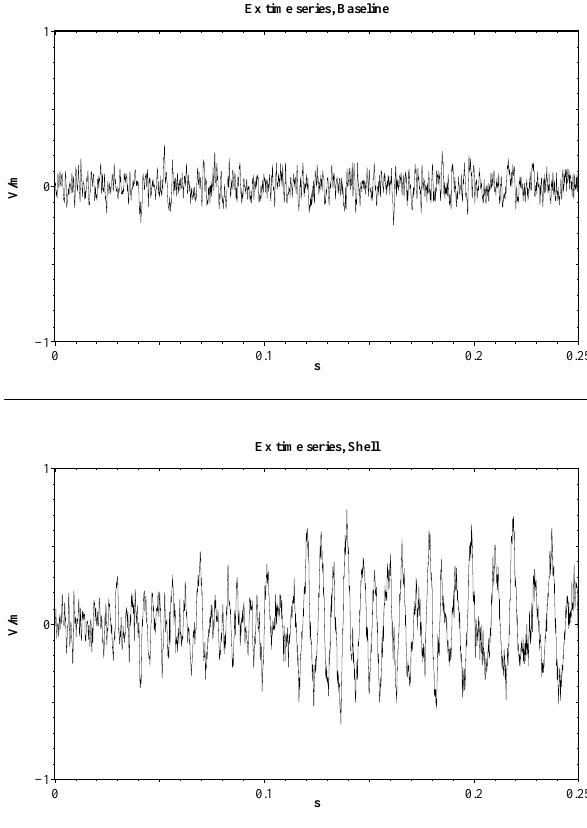
Fig. 10. Time series of the perpendicular electric field E x at one z value in baseline run (upper panel) and shell distribution run (lower